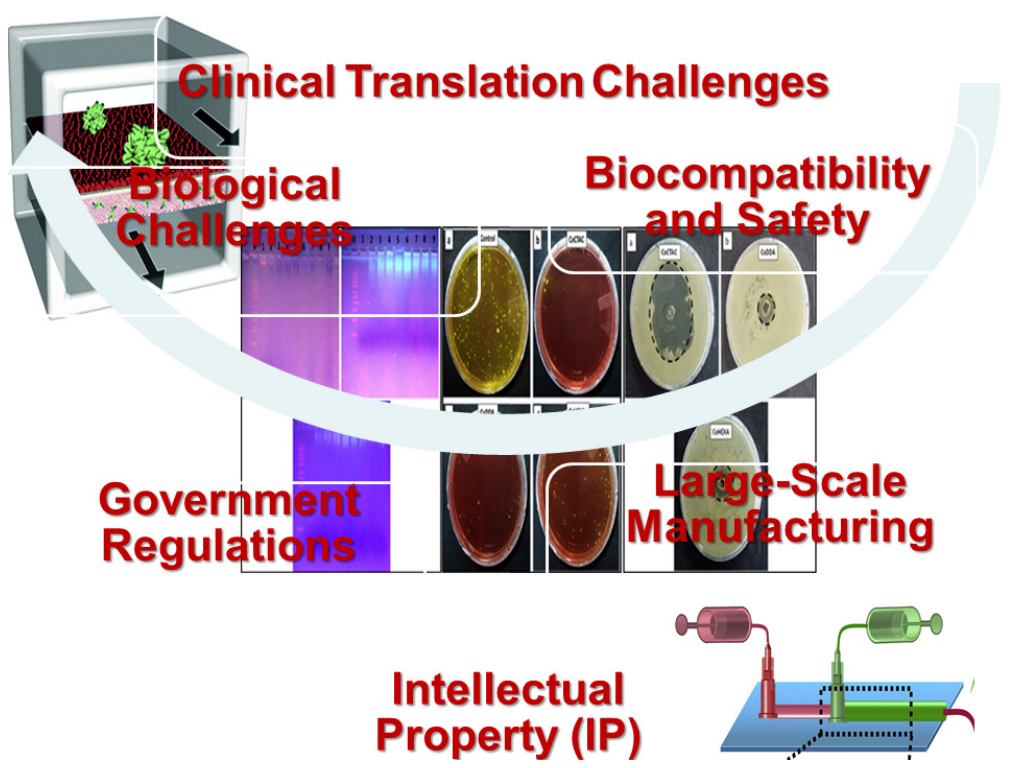
Figure 3. Graphical representation of the challenges in the clinical translation of nanomedicine.